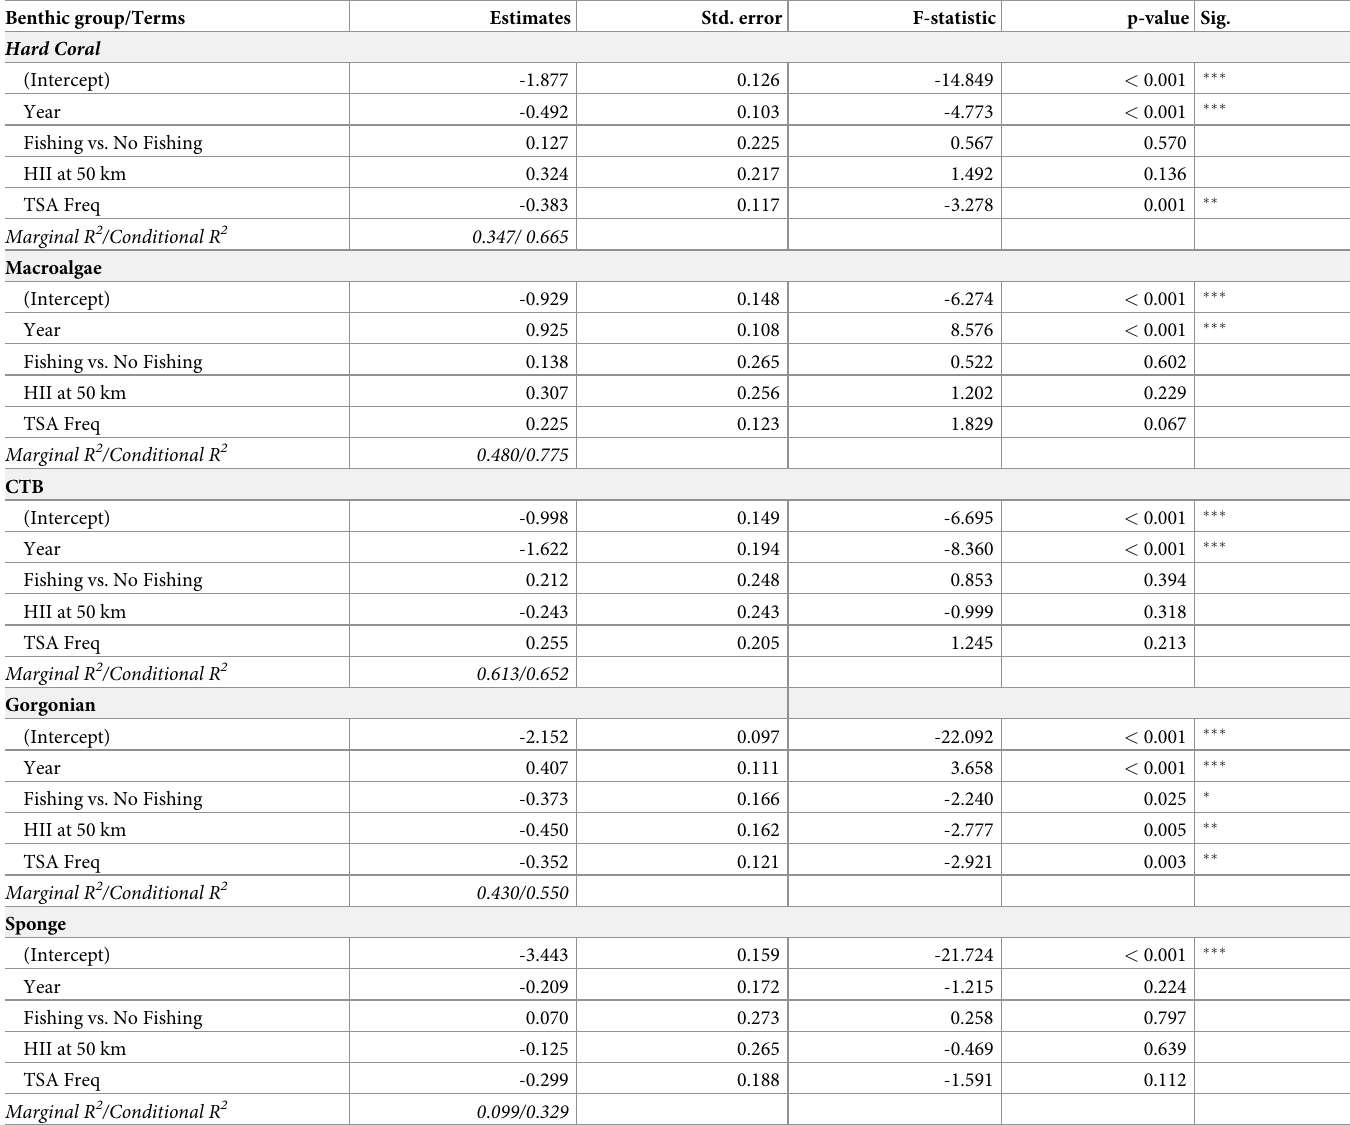
Table 3. Estimated regression parameters for the coverage of benthic